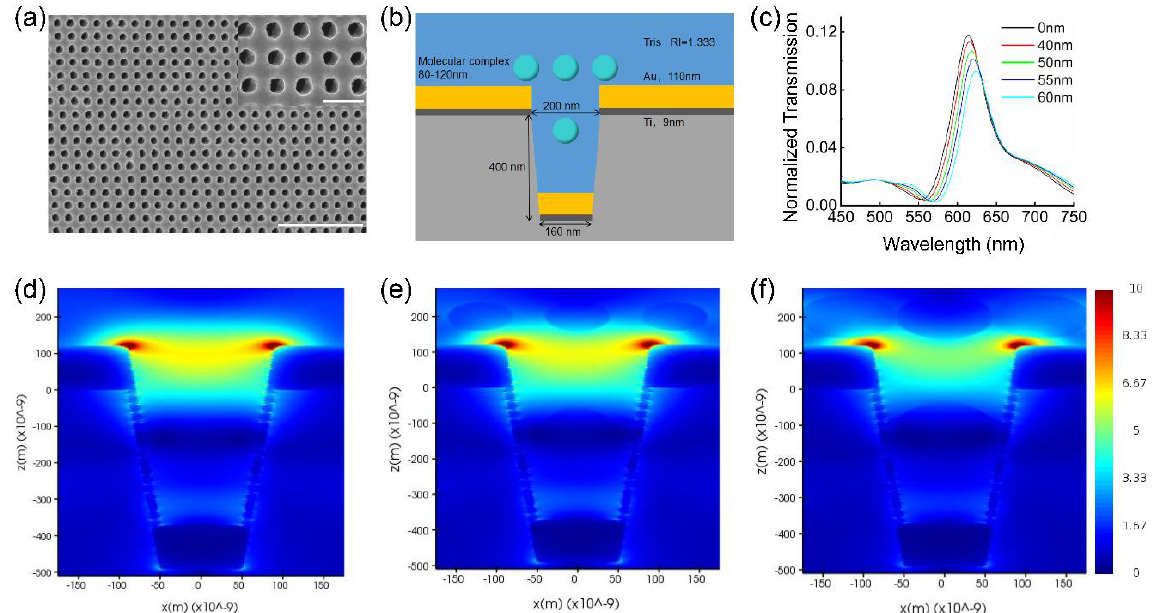
Figure 2. ( a ) SEM image of the fabricated nanocup sensor structure (Scale bar: 3000 nm). Inset: at high magnification (Scale bar: 500 nm) ( b ) Simulation model of the nanocup plasmonic sensor. ( c ) Simulated transmission spectra of the nanocup with different sizes (radius = 0, 40, 50, 55 and 60 nm) of immune complex molecules. ( d – f ) Near-field electric field distributions of plasmonic nanocup at resonance wavelength with immune complex particles at a radius of 0 nm ( d ), 40 nm ( e ), and 60 nm ( f ).